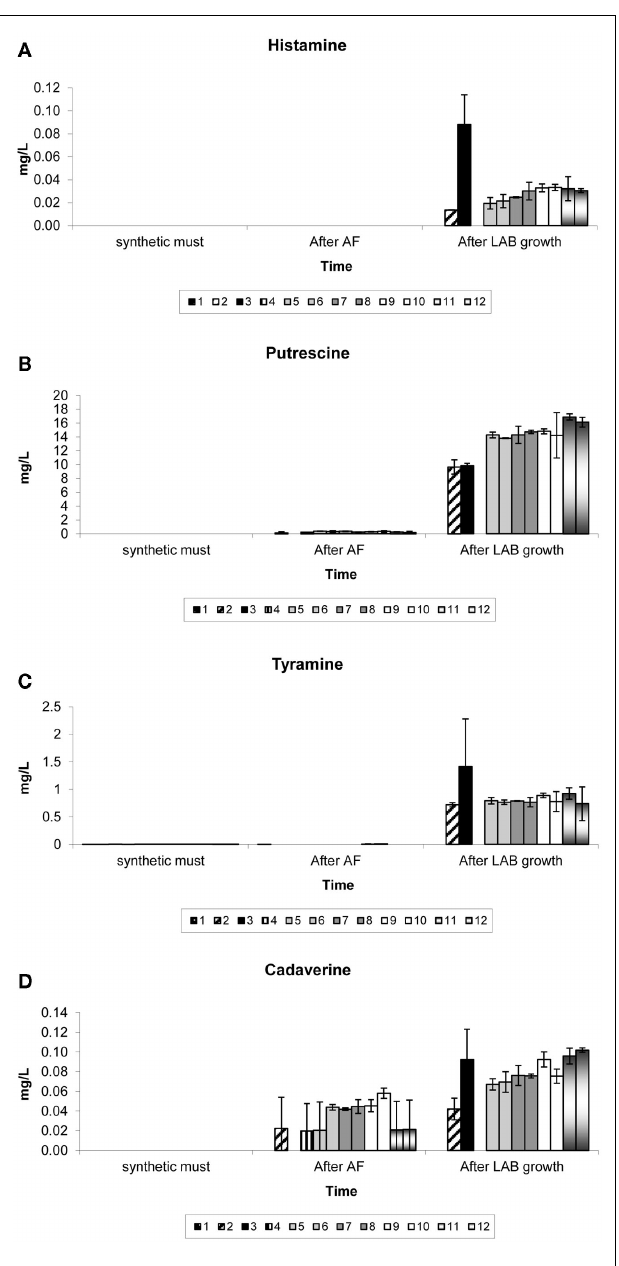
control in the Shiraz that only differed significantly from the concentration before